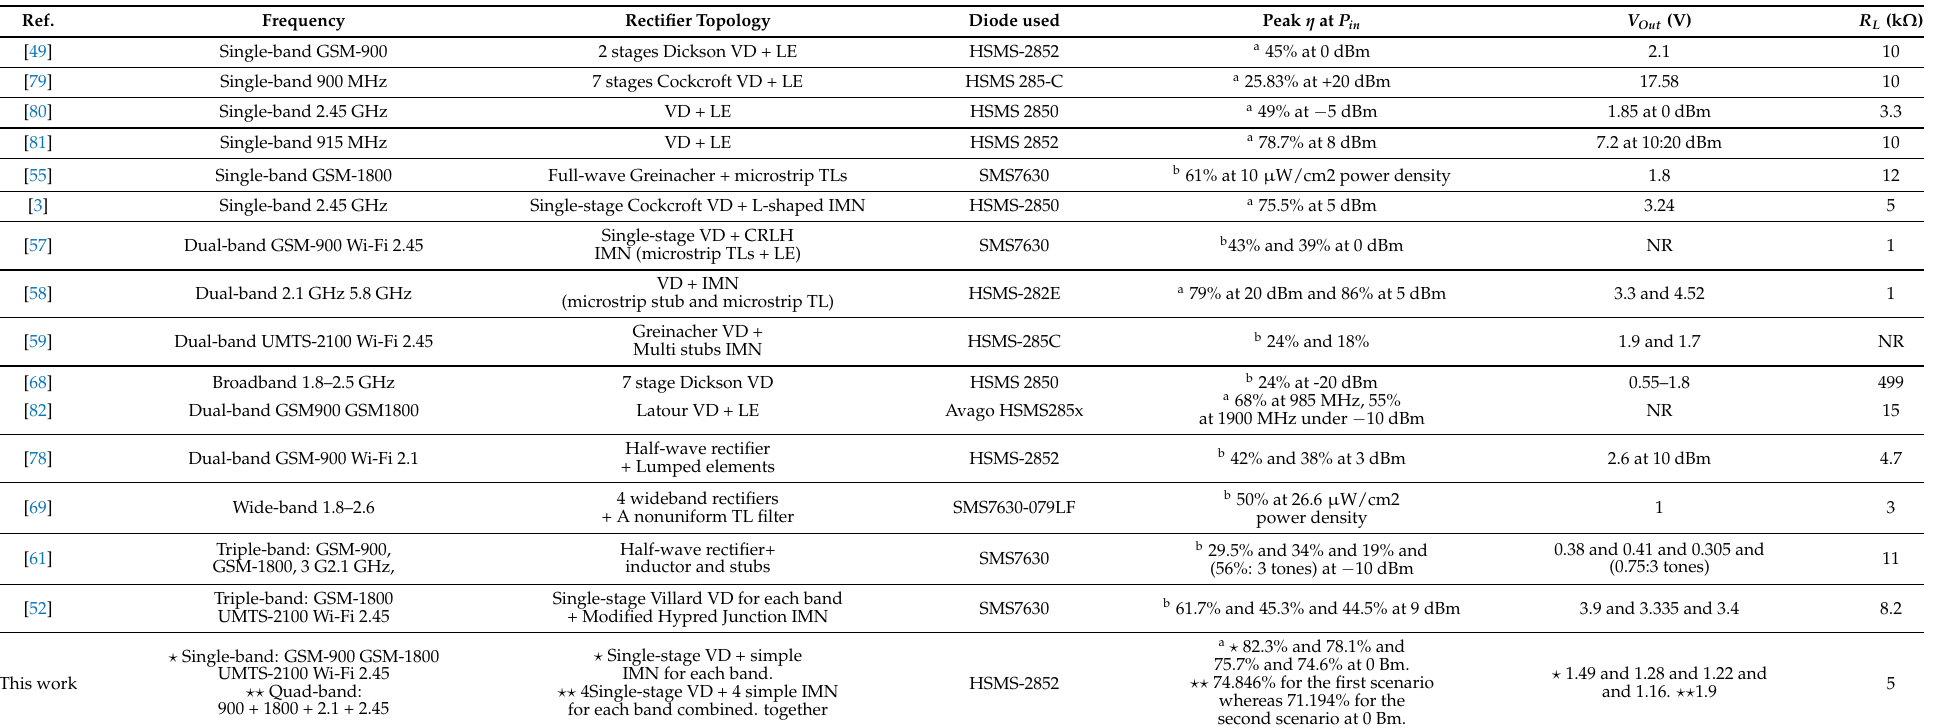
Table 4. A comparison with the related reported